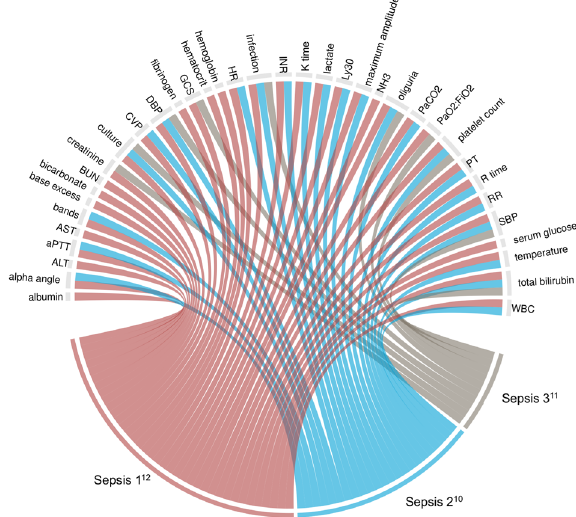
Fig. 2 Chord diagrams showing the representation of clinical elements across international consensus de fi nitions for sepsis. Ribbons connect from each of three international consensus de fi nitions for sepsis to data elements. Only those data elements encompassed by sepsis consensus de fi nitions are displayed. Abbreviations: ALT alanine aminotransferase, aPTT activated partial thromboplastin time, AST aspartate aminotransferase, BUN blood urea nitrogen, CVP central venous pressure, DBP diastolic